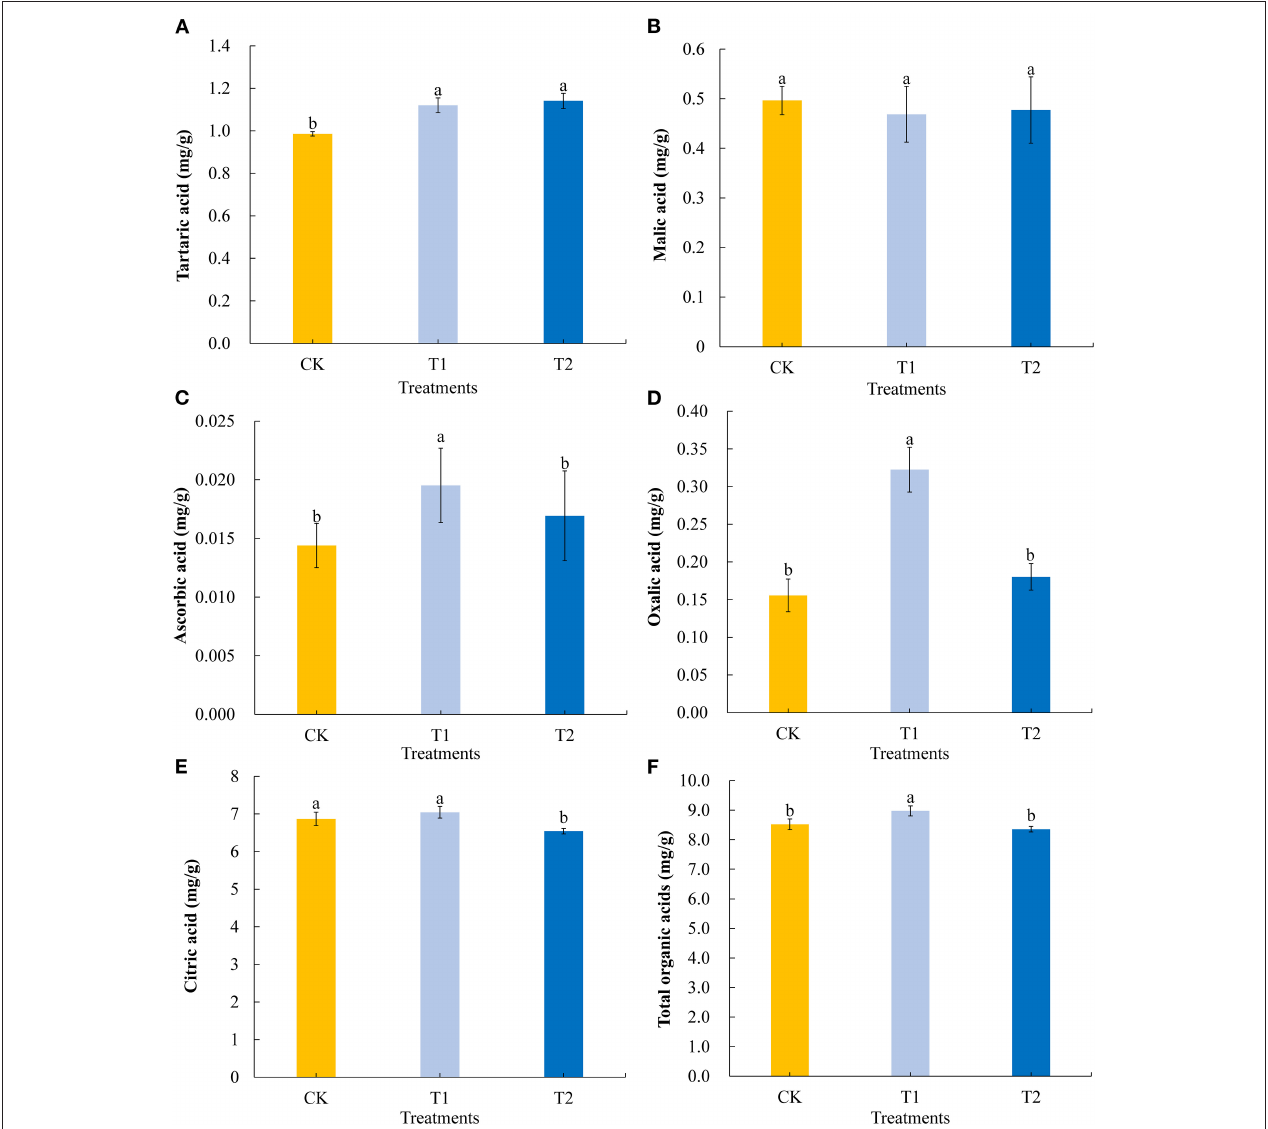
FIGURE 3 | Tartaric acid (A) , malic acid (B) , ascorbic acid (C) , oxalic acid (D) , citric acid (E) , and total organic acids (F) contents in tomato fruits under different LED supplementary light periods. The data are expressed as average values ± SD ( n = 3). a − c Indicate significant differences between treatments ( P < 0.05, Duncan’s multiple range test). The bars indicate standard errors. CK, no light supplementation control; T1, light supplementation for 3h in the morning; T2, light supplementation for 3h in the